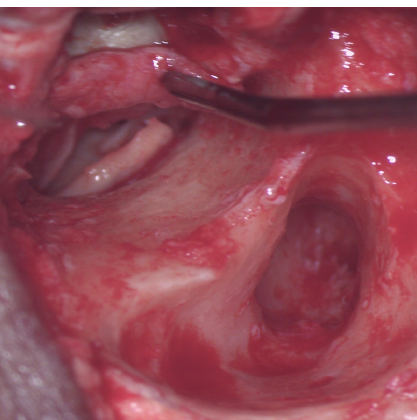
Figure 1: Cartilage piece being kept medial to the handle of malleus.